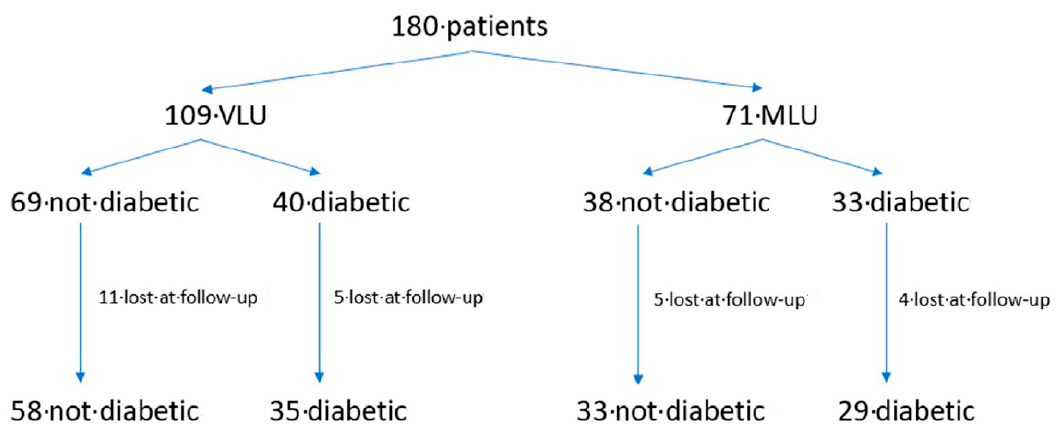
Figure 1. Consort Diagram of the case series.